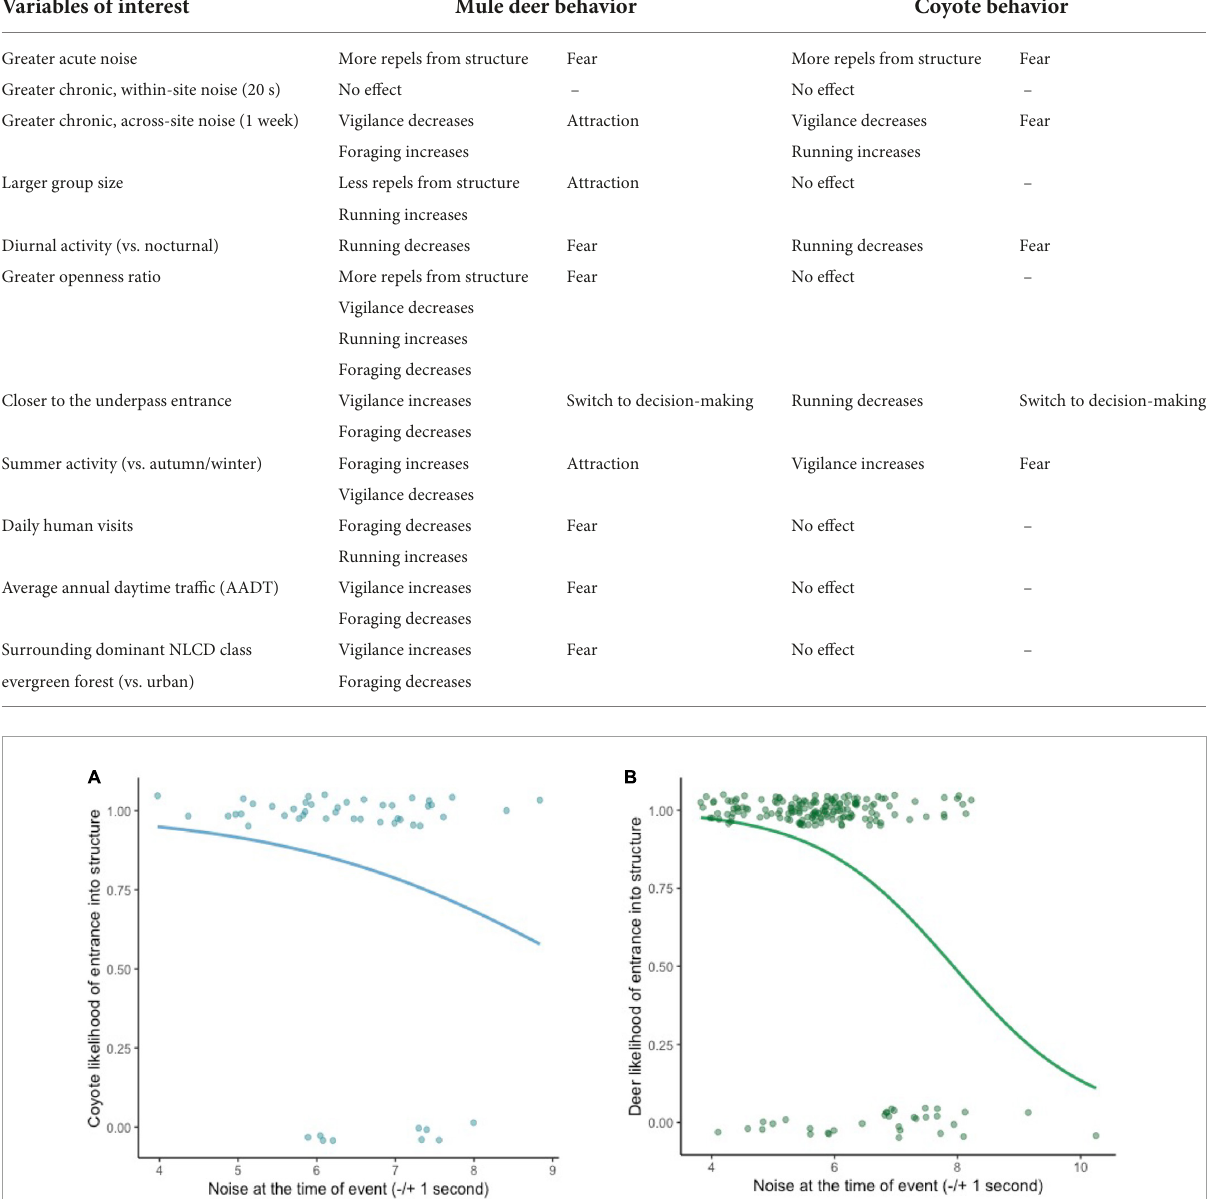
FIGURE3 Landscape of fear response: Likelihood of (A) coyotes and (B) deer entering the crossing structure (1 = enter, 0 = repel) in response to acute noise ( ± 1 s) at time of decision-making